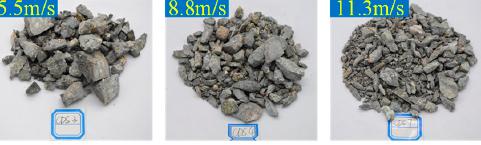
Figure 3. Dynamic fracture morphology of concrete under different numbers of freeze–thaw cycles.